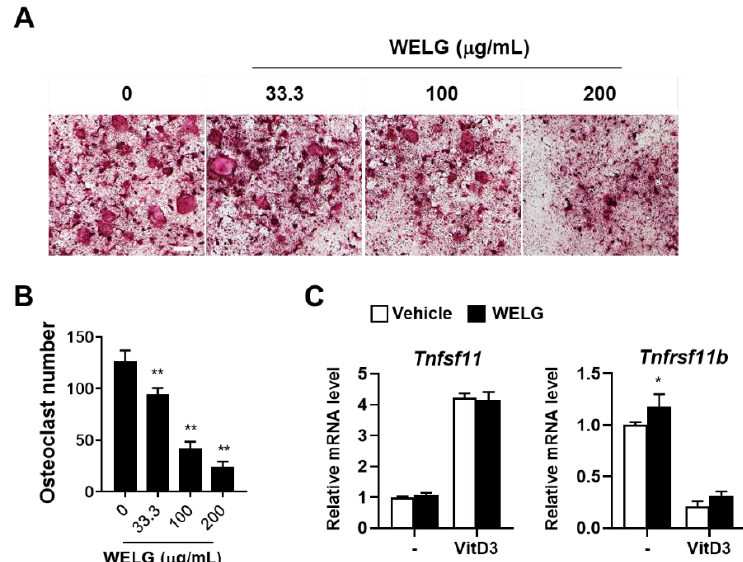
Figure 1. Suppression effect of WELG on osteoclast formation in co-cultures of osteocytes and osteoclast precursors. The co-cultures of MLO-Y4 and BMMs were treated with or without WELG for 5 days in the presence of VitD3 (10 nM). ( A ) Representative TRAP-staining images of the co-cultures (scale bar, 100 μm). ( B ) The number of osteoclasts, TRAP-stained multinucleated cells including more than three nuclei. ( C ) MLO-Y4 cells were treated with or without WELG (200 μg/mL ) and VitD3 (10 nM) for 1 day. Tnfsf11 and Tnfrs11b mRNA expression levels were quantified by quantitative